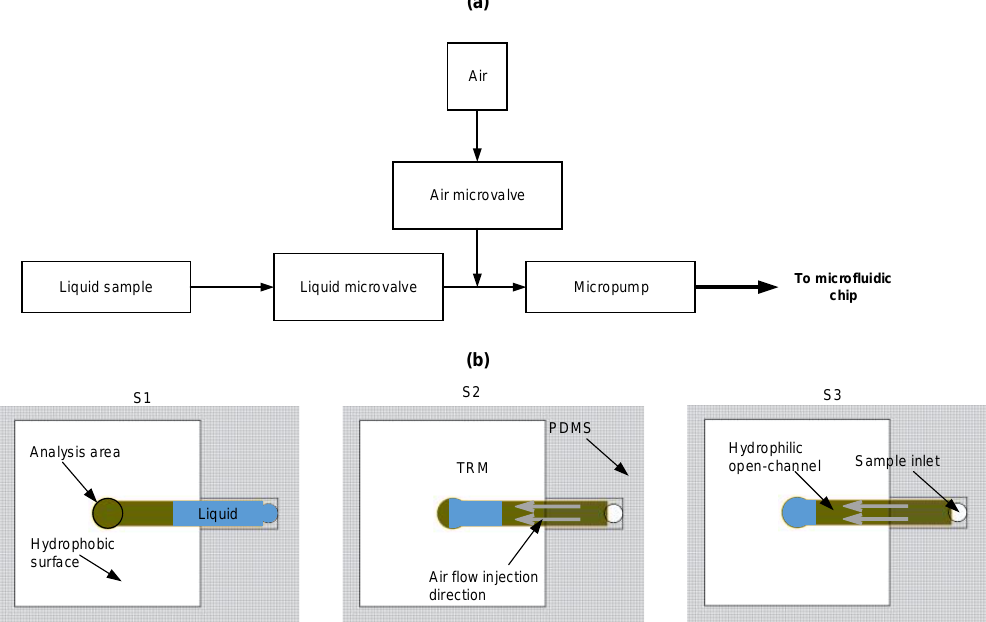
Figure 4. ( a ) Pumping unit diagram. ( b ) Microfluidic sample handling steps: (S1) is the initial step where the liquid is injected; (S2) is the second step where the liquid is sampled by air injection; and (S3) is the last step where air is continuously injected to keep the liquid far from the PDMS chamber walls during the solvent